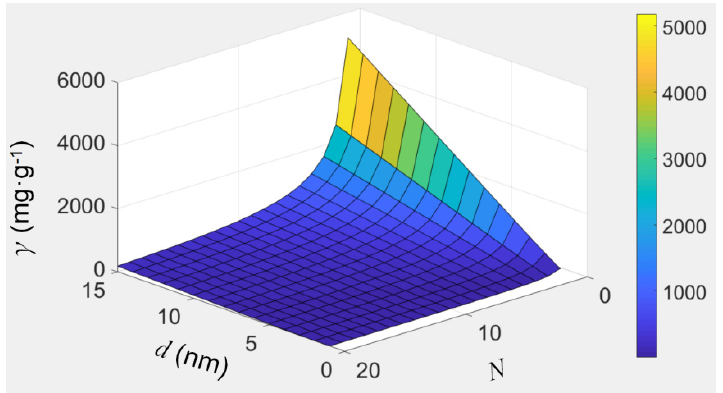
Figure 7. The visualization of equation 6, which shows how the filling capacity of CNTs, γ , varies with the inner diameter, d , and the total number of layers, N . with the inner diameter, d , and the total number of layers, N